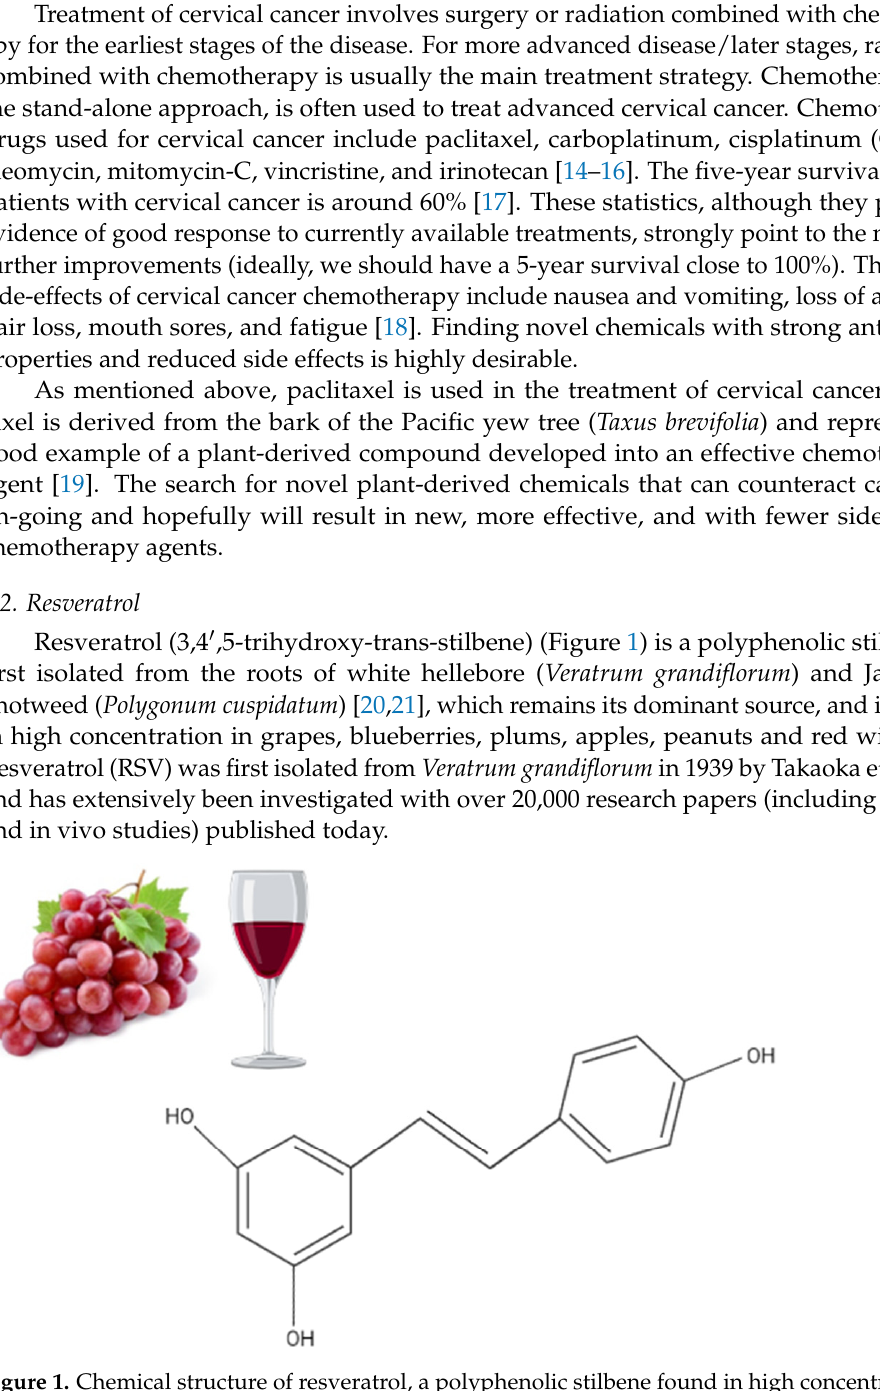
Figure 1. Chemical structure of resveratrol, a polyphenolic stilbene found in high concentration in grapes and red wine.